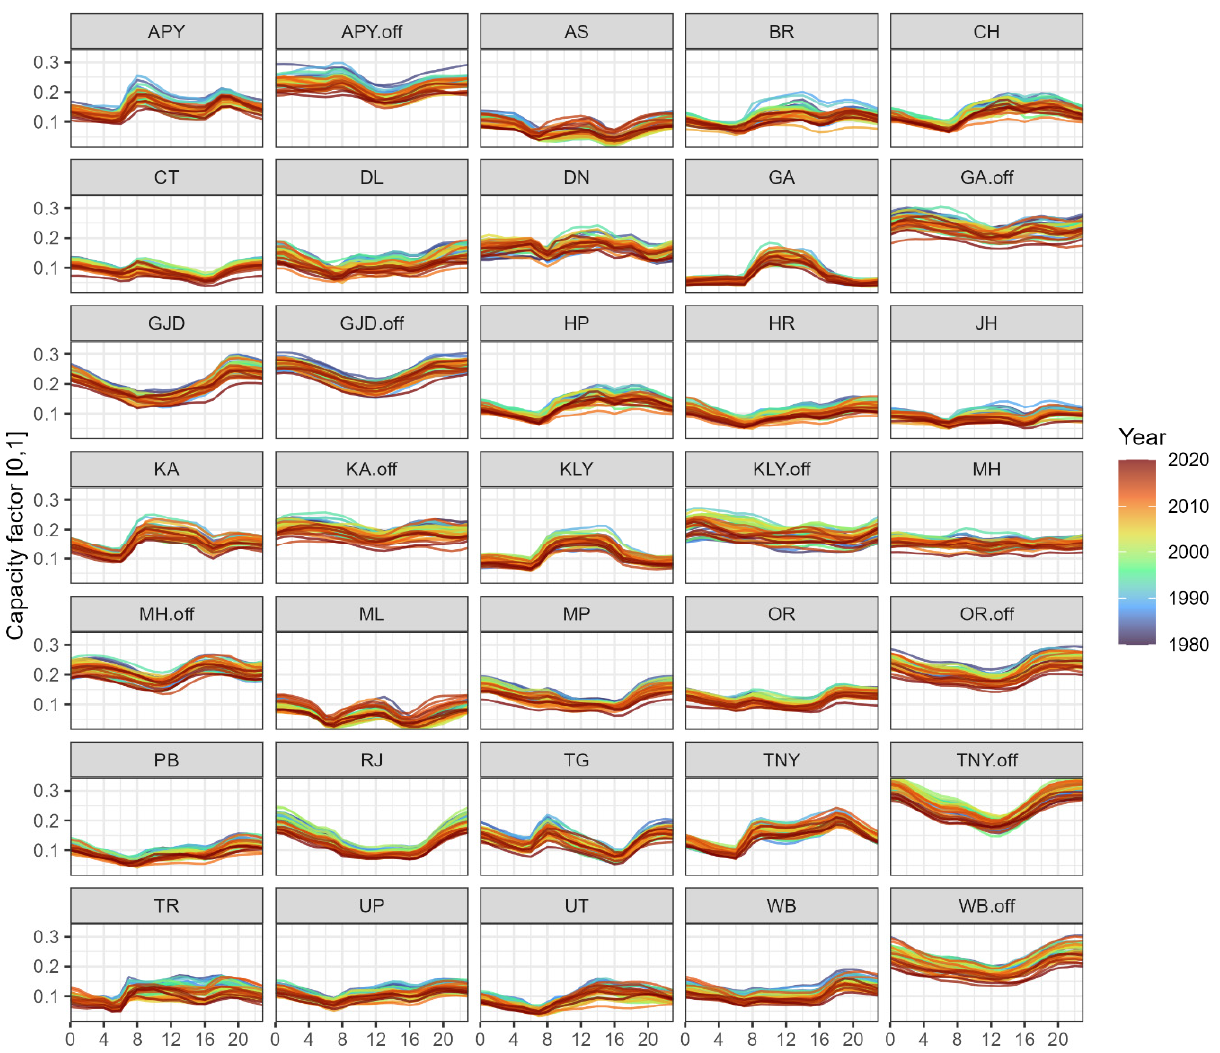
Figure 4. Annual average generation profile of wind turbines at 50 m hub height by year and region, onshore and offshore (.off) locations. Note: The figure demonstrates relative consistency in diurnal wind speed profile during a year in different regions.